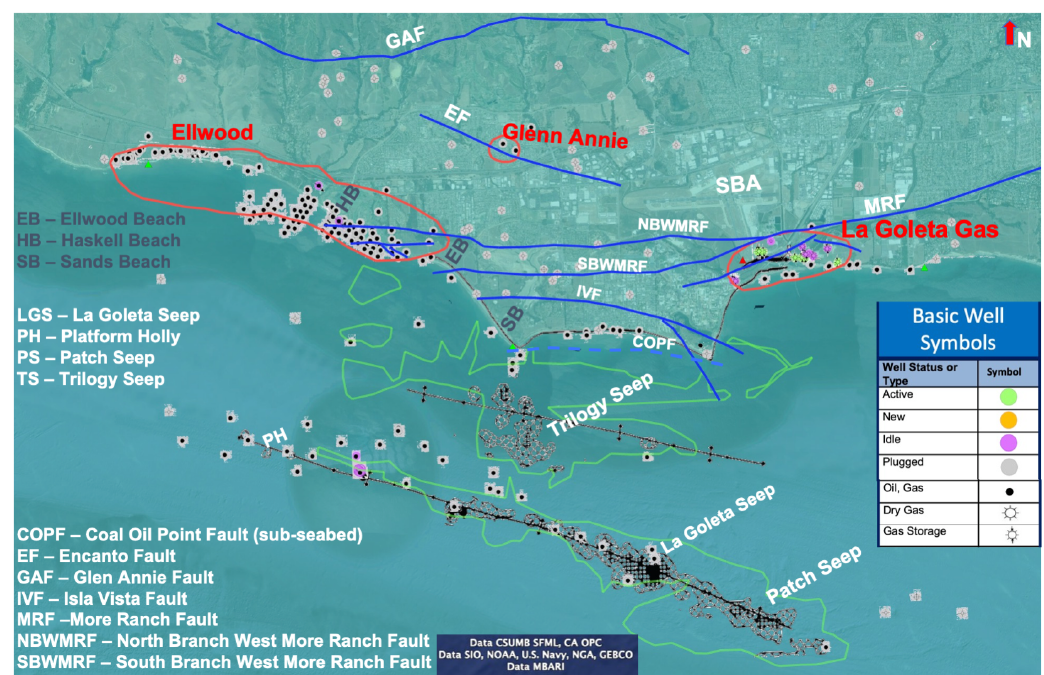
Figure 10. Map of the Goleta Plains oil and gas fields, wells, and the Coal Oil Point (COP) seep field. Grey hatching shows the 1995 field ex- tent, and green outlines the 1940 field extent from Leifer (2019). Field locations are from Olson (1983). Well data are from CDOGGR (2018). Faults are from Minor et al. (2009). Seep names are informal. Data keys are shown in the panels. Shown in the © Google Earth